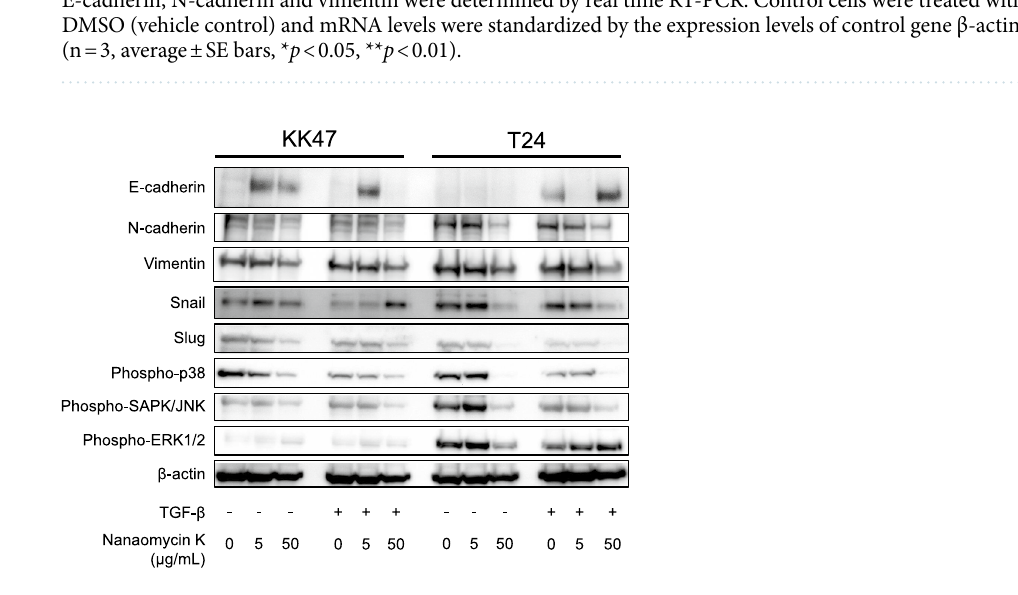
Figure 4. Western blotting for EMT and MAPK signaling. The expressions of E-cadherin, N-cadherin, vimentin, Snail, Slug, phopho-p38, phospho-SAPK/JNK, phospho-ERK1/2, and β-actin were determined in the presence of nanaomycin K (5 µg/mL or 50 µg/mL) with or without TGF-β in vitro for 48 h in KK47 and T24 cells. Full-length blots are presented in Supplementary Figure